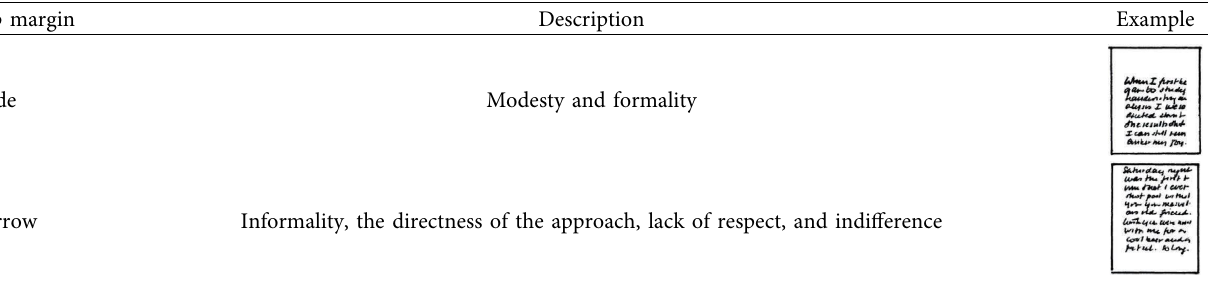
Table 6: Te top margin features and their corresponding types.